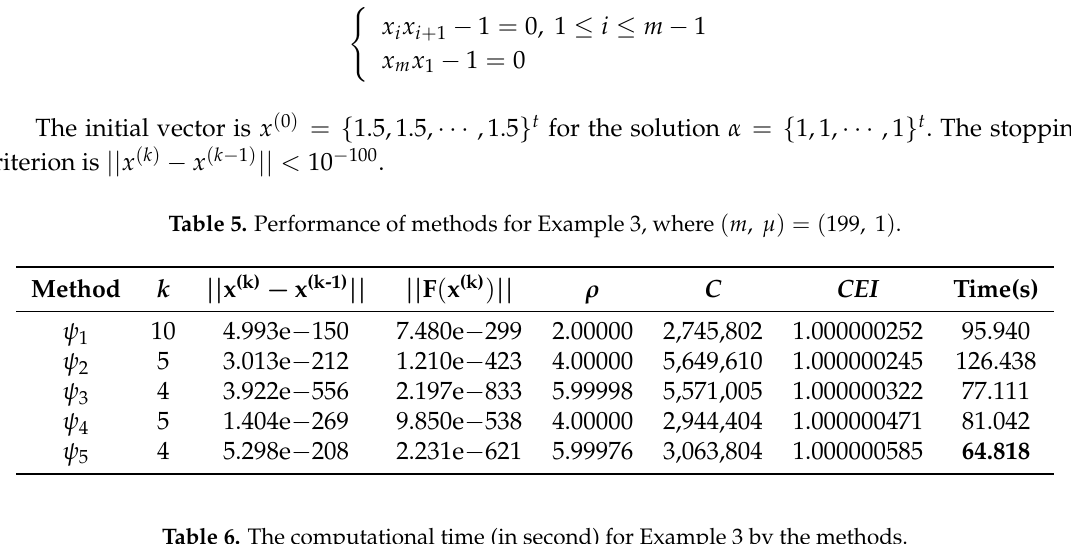
Table 6. The computational time (in second) for Example 3 by the